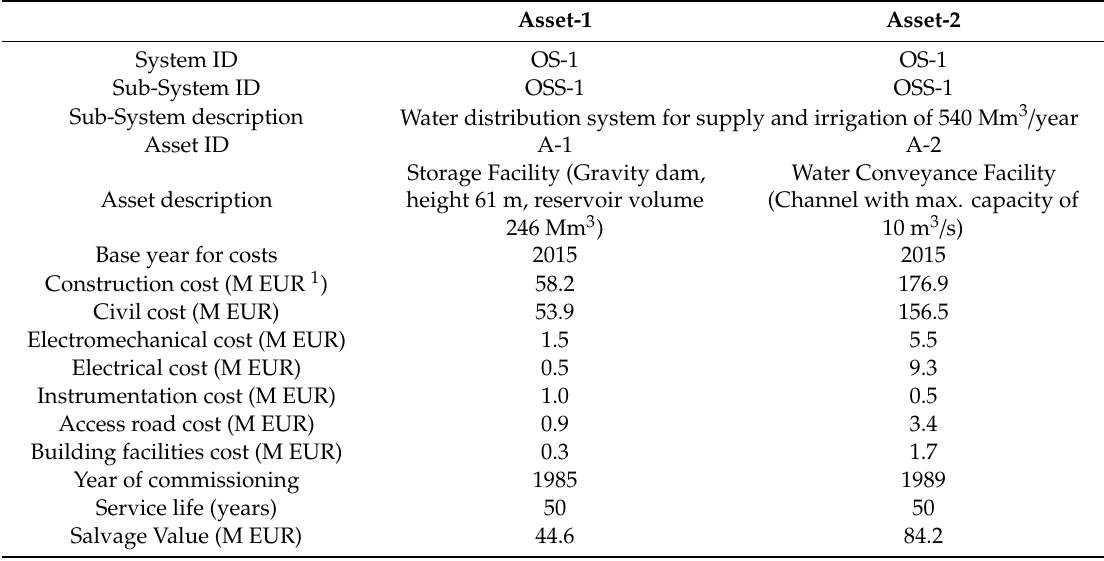
Table 4. Description of